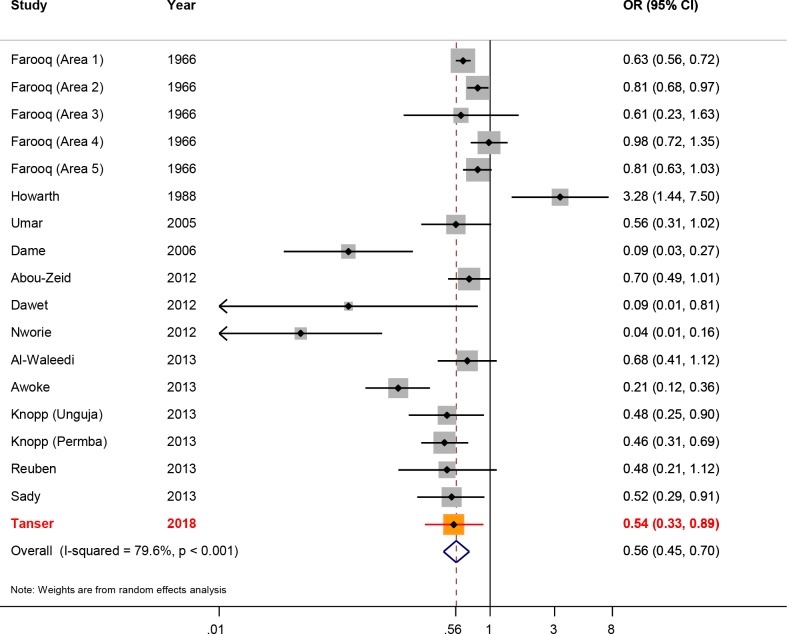
Forest plot of Schistosoma haematobium infection according to household/individual level access to a safe water.The data are taken from Grimes et al. systematic review (Grimes et al., 2014), based on 17 data-points (Abou-Zeid et al., 2012; Al-Waleedi et al., 2013; Awoke et al., 2013; Dame et al., 2006; Dawet, 2012; Farooq et al., 1966; Howarth et al., 1988; Knopp et al., 2013; Nworie et al., 2012; Reuben et al., 2013; Sady et al., 2013) to which we have added our study results. The sizes of the squares represent the weight given to each study, the rhombus is the effect-size with the black lines representing the 95% confidence intervals. The overall rhombus represents the combined effect-size, with the results of this study shown in red.